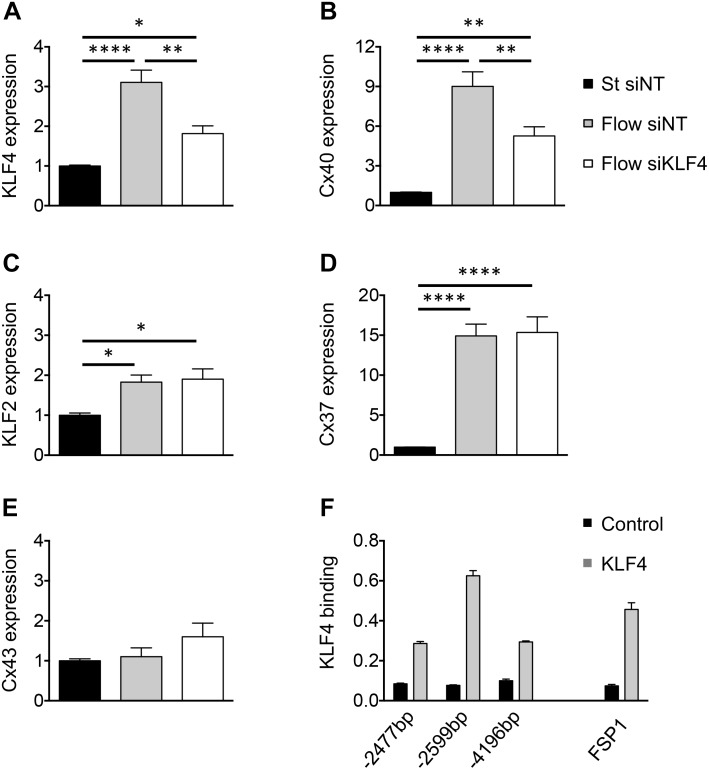
KLF4 regulates flow-dependent Cx40 expression. KLF4 (A), Cx40 (B), KLF2 (C), Cx37 (D) and Cx43 (E) expression in bEnd.3 cells transfected with KLF4 siRNA or NT siRNA and subsequently exposed to 48 h of HLSS or kept under static conditions. N = 6. (F) Representative ChIP results for bEnd.3 chromatin precipitated with antibodies against KLF4. Three different CACCC KLF-consensus sites (indicated in bp) were amplified for Cx40 (left) and one for FSP1 (right; positive control). Levels of DNA are normalized to input. N = 2.